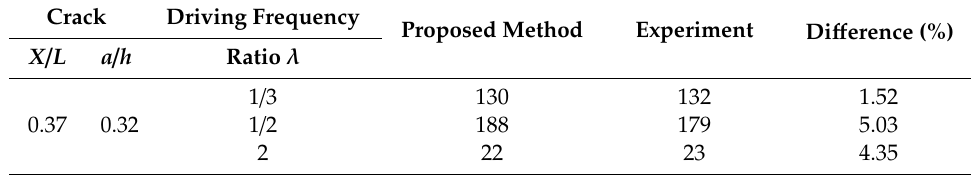
Table 1. Comparison of the forced response of dominant harmonic amplitude from the proposed method and experiment for di ff erent driving